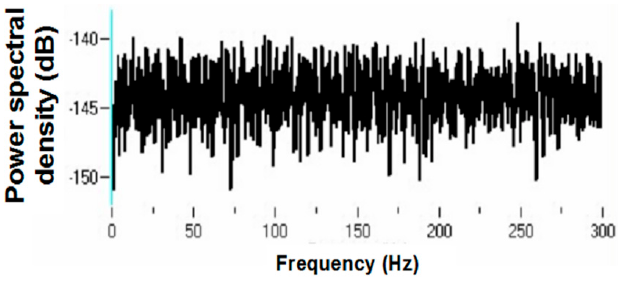
Figure 20. Representative power spectral density of an original train prior to DBS.